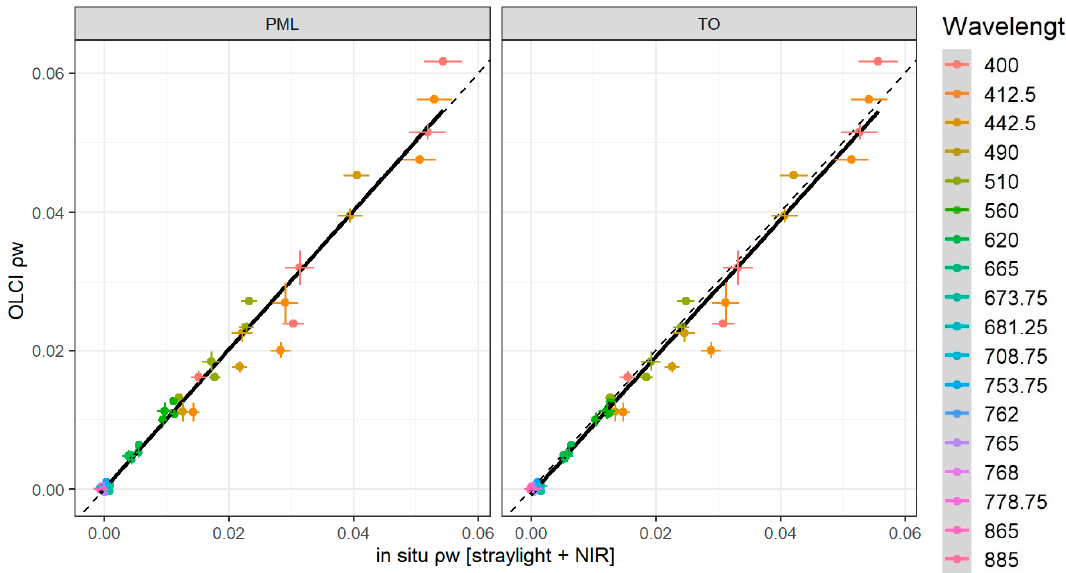
Figure 14. Correlation between OLCI-derived and in situ-measured ρ w processed with straylight and NIR similarity correction over five match-ups over all wavelengths. The error bars denote respective uncertainties for in situ data and standard deviation inside the ROI for OLCI. Table 3. The Mean Absolute Percentage Difference (MAPD) and Mean Percentage Difference (MPD) as calculated between Ocean Land Colour Instrument (OLCI) and in situ 𝜌 w data measured by TO or PML over five match-up stations. Straylight and NIR similarity correction was applied to in situ data. The mean in situ uncertainty for both radiometers is shown in the right column.